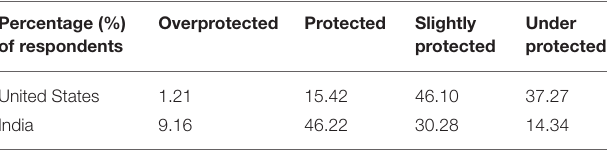
TABLE 9 | Responses from the United States and India to the question “How well do you think dolphin and whale species are protected worldwide?” Percentage (%) of respondents